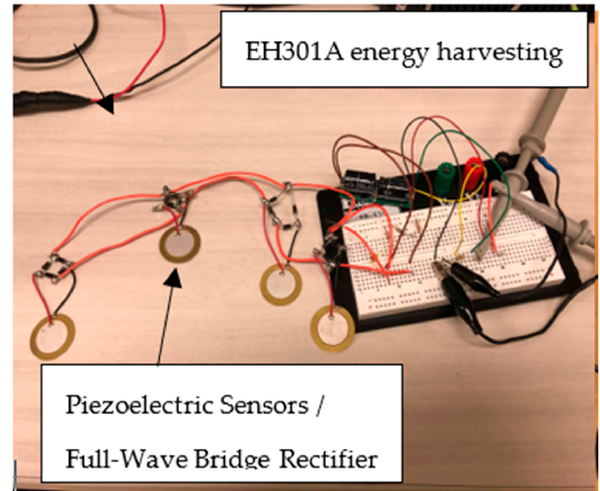
Figure 9. Testing the Power Generation Subsystem.